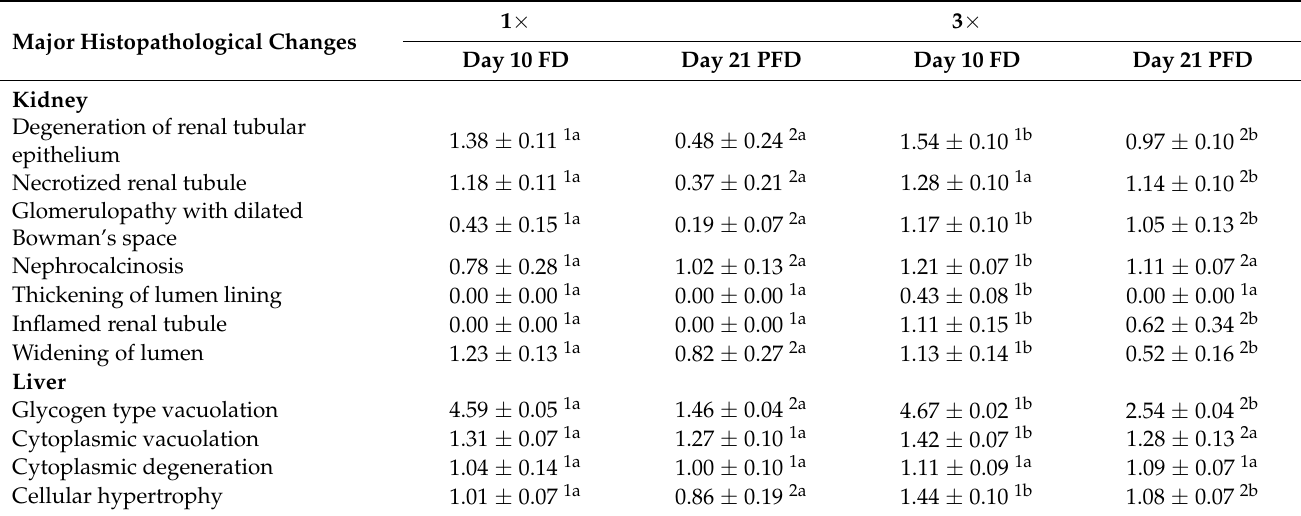
Table 4. Qualitative assessment of major histopathological changes in the kidney and liver tissues of florfenicol-dosed Nile tilapia Oreochromis niloticus juveniles at 0–3 times the therapeutic dose of the normal architecture.